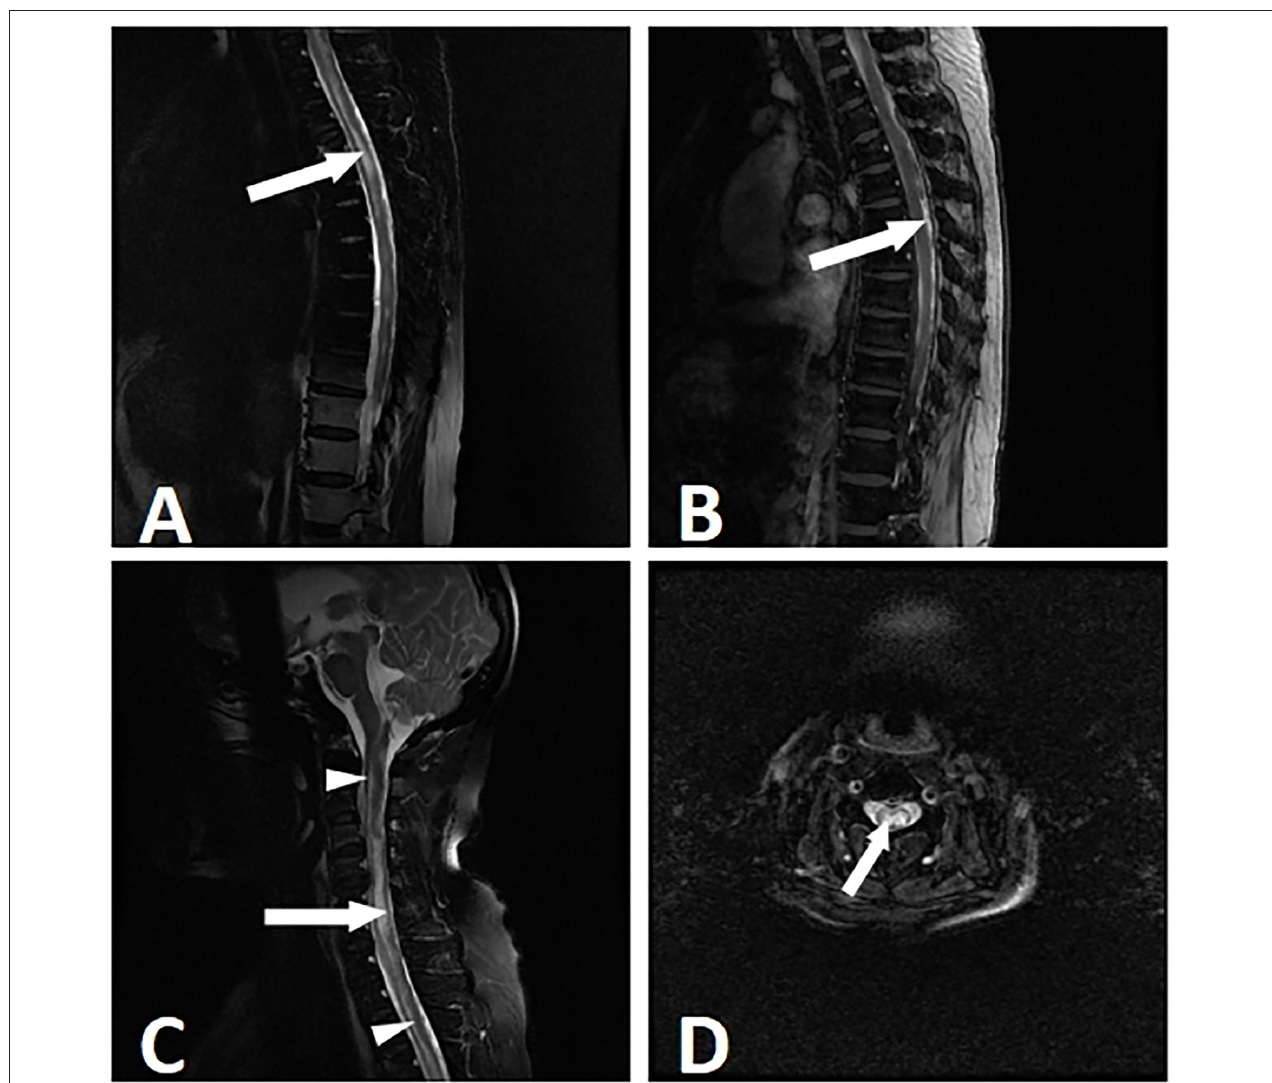
FIGURE 2 | Myelitis in a 53-year-old woman with tuberculous meningitis. The patient suffered from paraparesis with the duration of 8 weeks. MRI showed longitudinally myelitis. T2-weighted imaging showed a stripped-like hyperintensity (A) . In the T1 contrast-enhanced sequence, uneven enhancements of the lesions were noticed (B) . T2-weighted sagittal and axial images showed an uneven enlargement of the spinal cord and syringomyelia. The syringomyelia manifested as a stripe of intramedullary near-water signals (long arrow) and enlargement of the central canal (short arrow) (C,D)